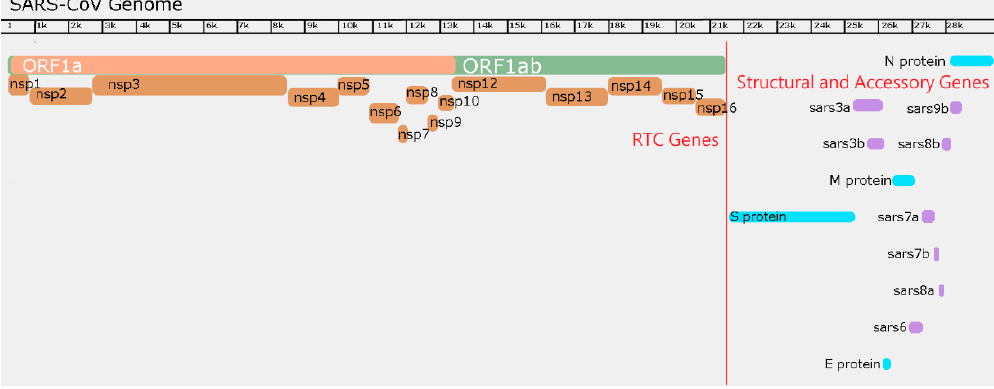
Figure 1. Genome graphic of SARS-CoV, showing where the genes encoding the recognized viral proteins